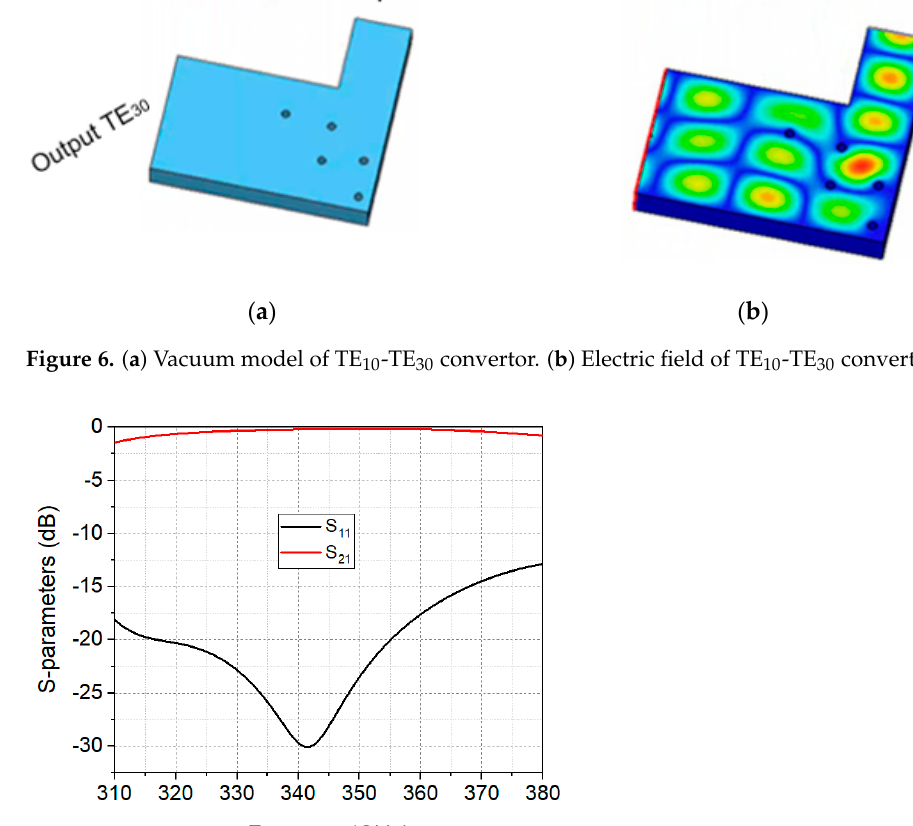
Figure 7. Simulation results of S-parameters for the TE 10 -TE 30 convertor.